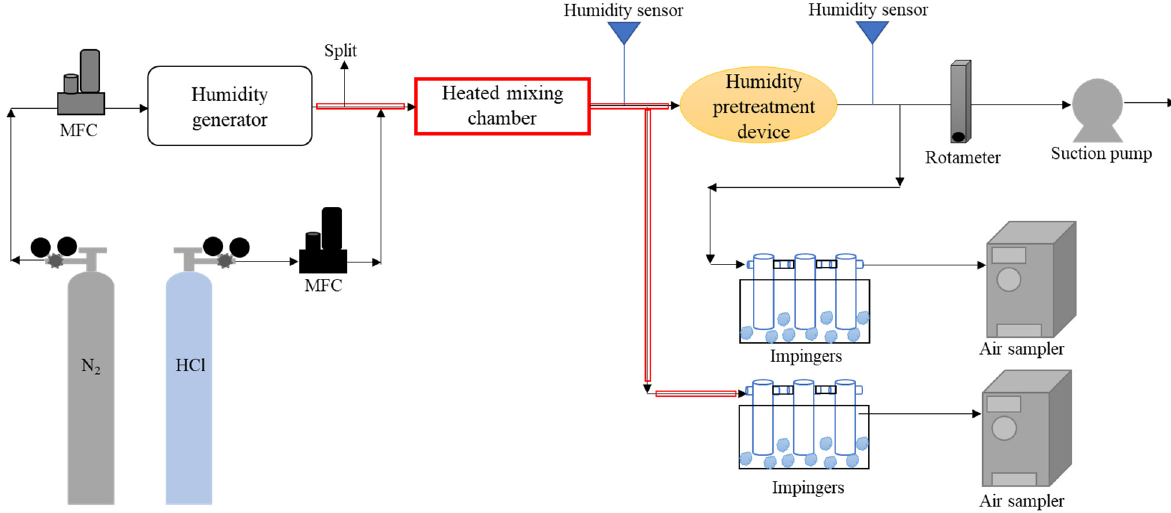
Figure 2. Experimental set-up for investigating the performance of humidity pretreatment devices.